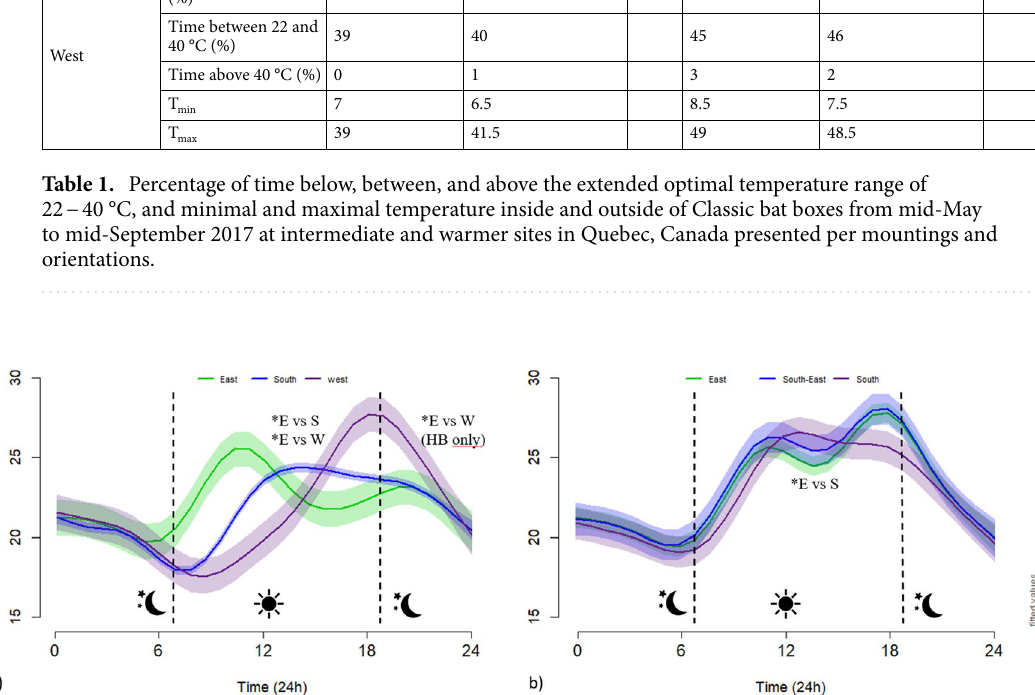
Figure 2. Estimated hourly patterns for the different bat box orientations in Quebec, in 2017. Bat boxes facing east (n = 4), south (n = 4), and west (n = 4) on buildings ( a ), and facing east (n = 2), south (n = 2) and south-east (n = 2) on poles ( b ). The estimated values are based on a generalized additive mixed model, accounting for time, date, external temperature, structure, site, and individual bat box identity. Values of fixed factors have been set to: date = July 6, external temperature = 18 °C. The asterisks (*) represent significant differences between orientations during the day and night. E = east, S = south, W = west, and SE = south-east. HB = heated